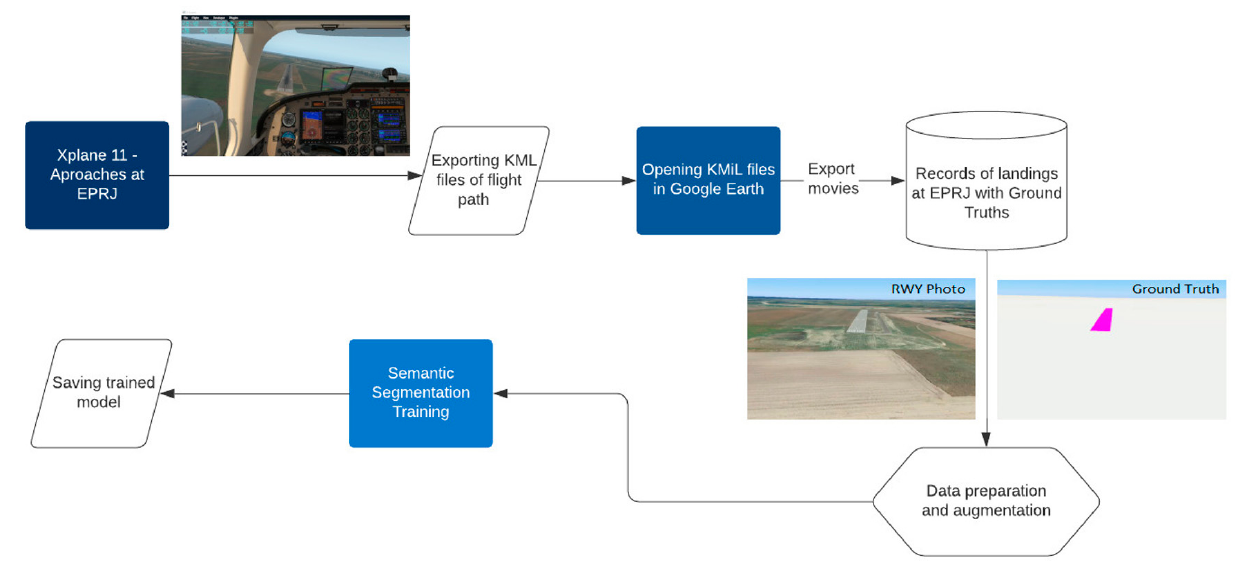
Figure 4. Proposed ANN learning methodology.